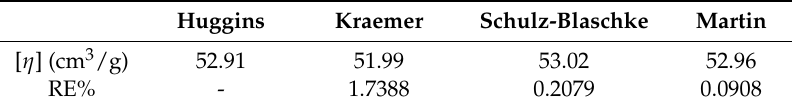
Table 2. Intrinsic viscosity obtained with different